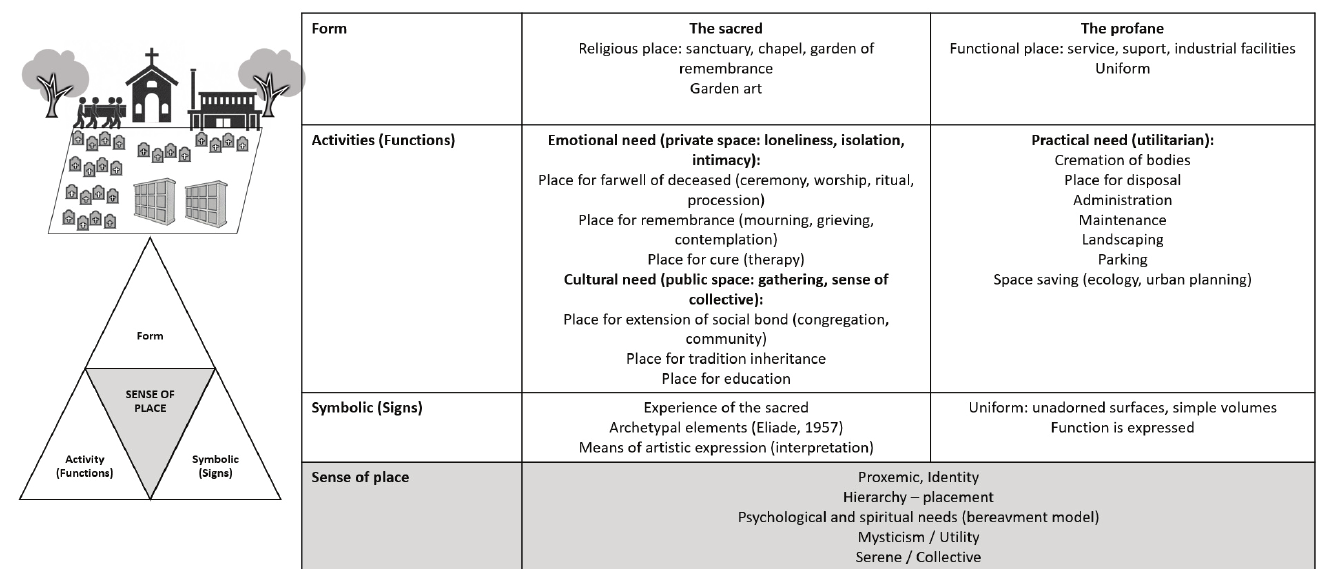
Figure 4. Diagram showing the multifaceted landscape for cremation practices (cemetery and crematorium). Own elaboration